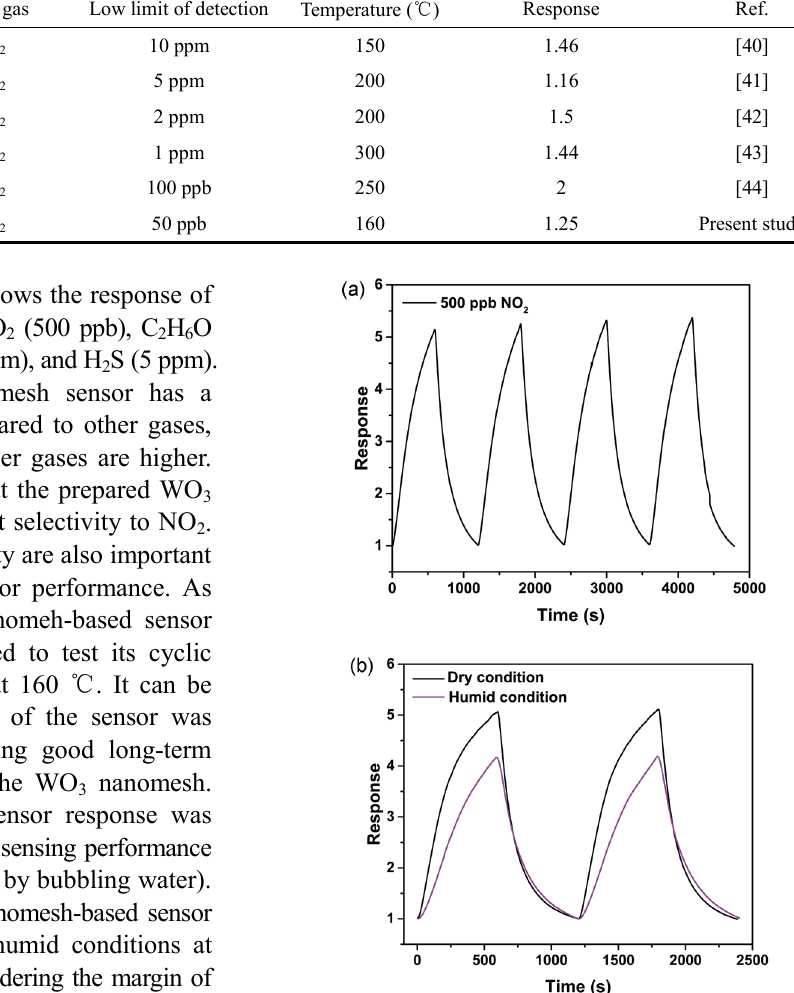
Fig. 8 (a) Cyclic response curve of WO 3 nanomesh sensor after 30 days of storage to NO 2 (500 ppb) at 160 ℃ ; (b) response curves of WO 3 sensor to NO 2 (500 ppb) at 160 ℃ in dry and humid